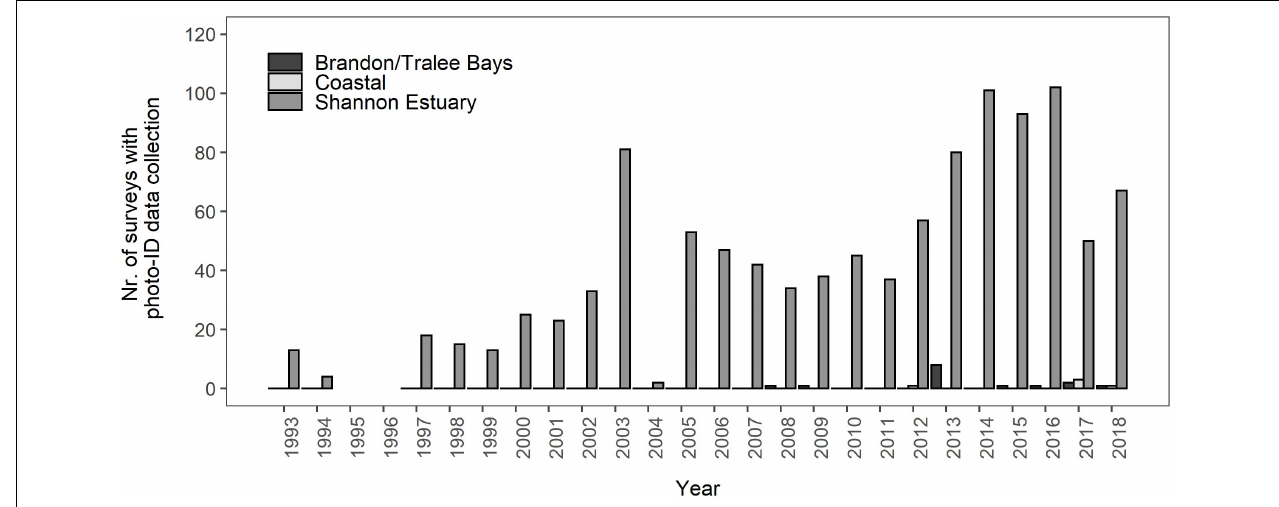
FIGURE 2 | Number of surveys, both dedicated and opportunistic, with photo-ID data collection per annum and per area (Brandon/Tralee Bays, Coastal, Shannon Estuary). No surveys were conducted in 1995 and 1996, resulting in the complete absence of photo-ID data from these years. All encounters in Brandon Bay in 2008/2009 and 2015 were opportunistic. Coastal encounters were entirely opportunistic and only counted when Shannon dolphins were part of the encountered